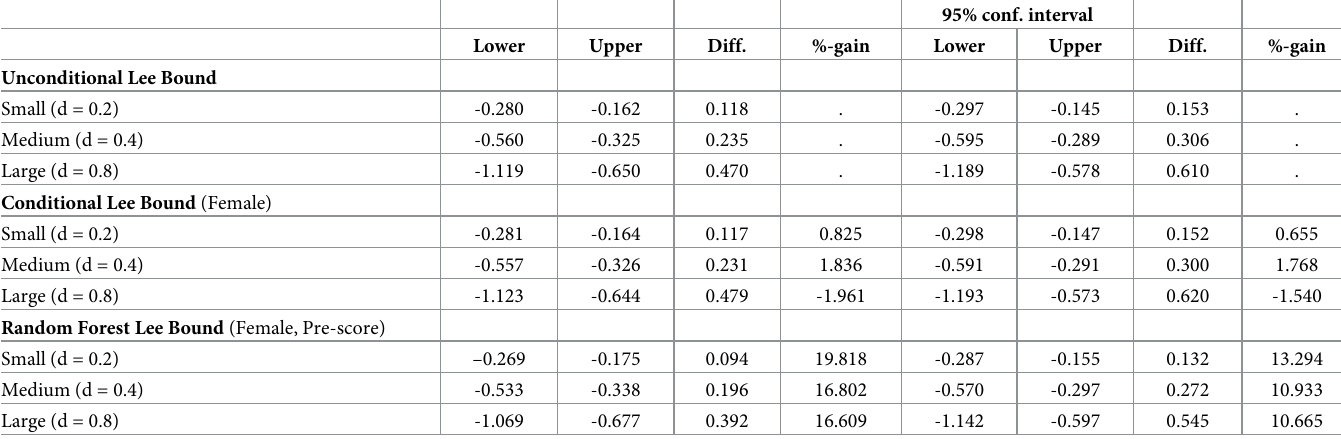
Table 2. Bounding estimation results for small, medium and large effect